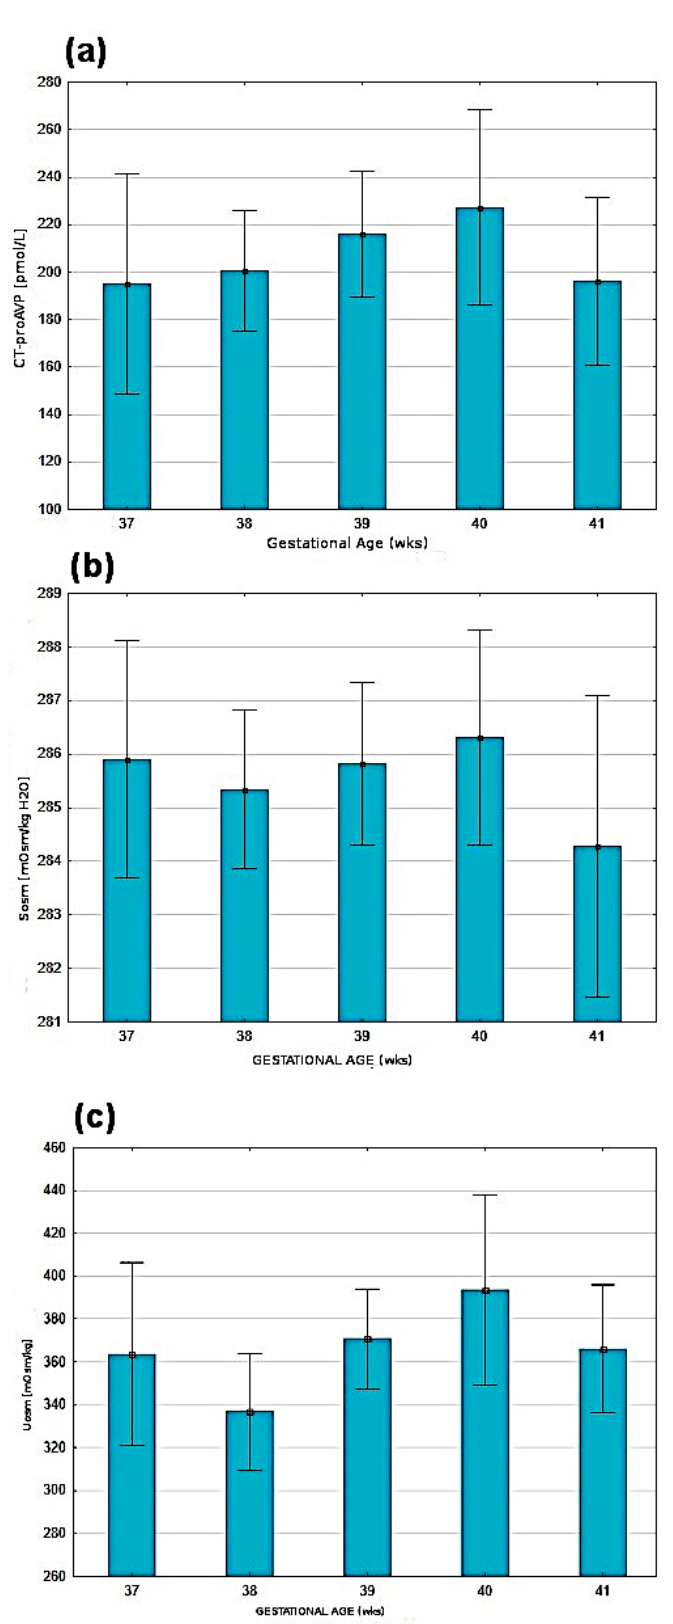
Figure 1. Presentation of selected parameters in relation to gestational age: ( a ) CTproAVP, ( b ) effective serum osmolality (Sosm) and ( c ) urine osmolality (Uosm). The values presented as means ± SD.